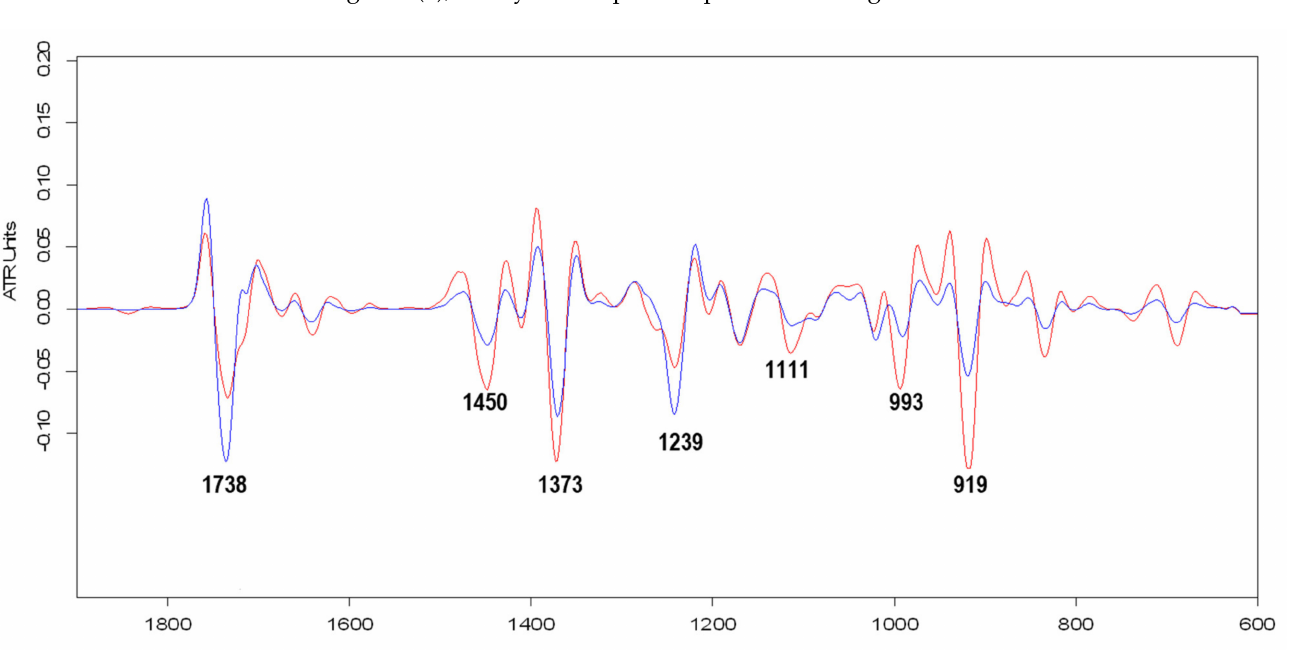
Figure 2. The second derivative spectra for the Var. Moldoveanca 4 (1), 2018 year (red), and Var. Vis magic 10 (3), 2017 year, (blue) LEOs